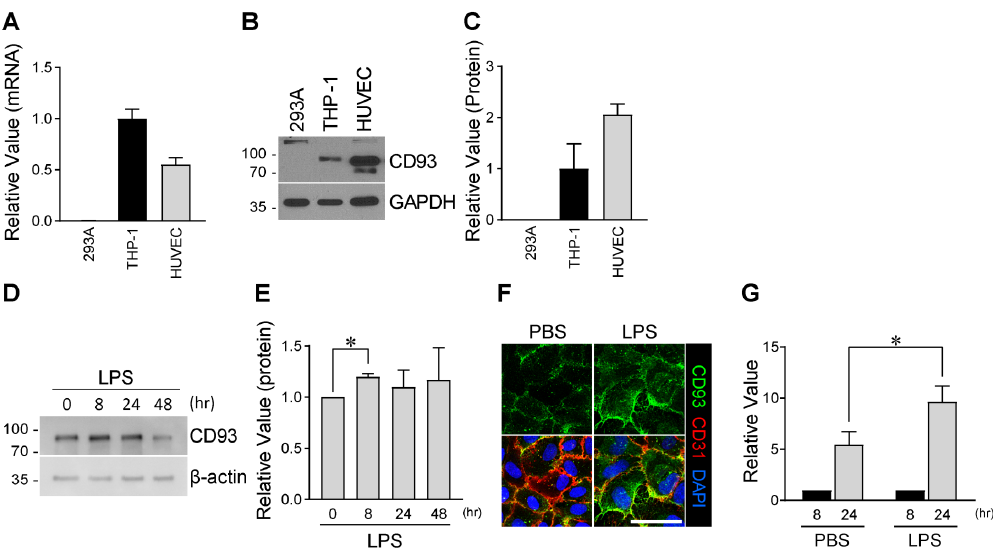
Figure 2. Expression of CD93 in human cells and its response to LPS. ( A ) The level of CD93 transcription was evaluated by qRT-PCR and presented as the relative value after normalization to GAPDH. The transcription level of sCD93 in THP-1 cells was set as 1 and compared between different types of cells (n = 4 per group). ( B ) The level of CD93 translation was immunoblotted with GAPDH as a loading control and ( C ) the value of CD93 relative to GAPDH was presented with the value of THP-1 as 1 (n = 4 per group). ( D ) HUVECs were harvested at the designated time point after LPS treatment and immunoblotted for CD93 expression. β-actin was used as a loading control. ( E ) The quantification of ( D ) was presented with the expression level at baseline set as 1 (n = 4 per group). ( F ) The localization of CD93 in the HUVECs was visualized by immunofluorescent staining with CD93, CD31, and DAPI after 48 h of 500 ng/mL LPS stimulation. Scale bar, 50 μm. ( G ) The supernatant of cultured HUVECs was harvested after 8 h or 24 h of 500 ng / mL LPS stimulation and the sCD93 level was measured by ELISA. All values are fold change compared to the value of 8 h without LPS stimulation as the control. The di ff erence was compared between the PBS and the LPS group (n = 4 per group). Data are presented as the mean ± SE. * p <